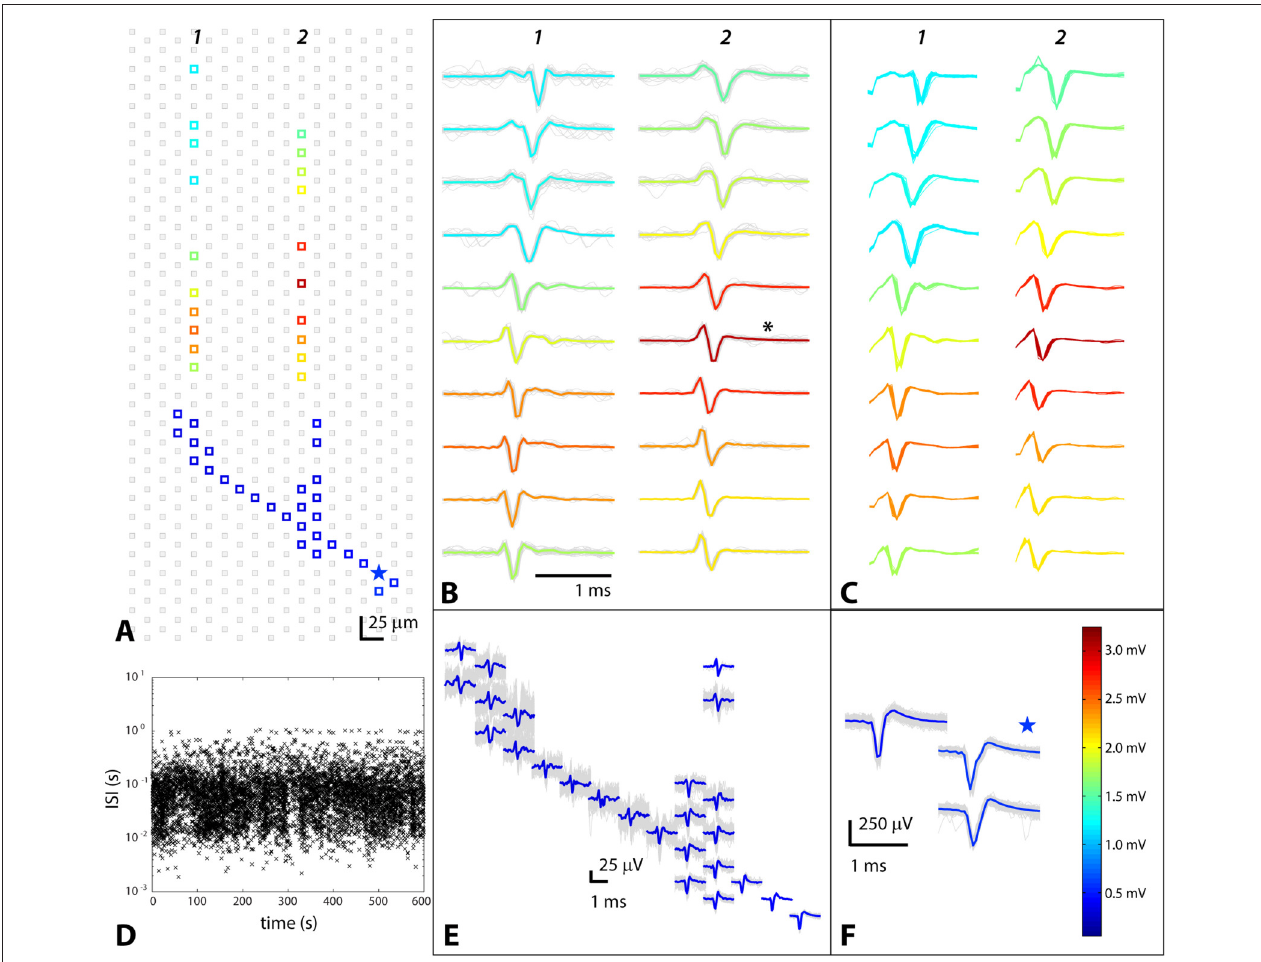
FIGURE 1 | Triggered spontaneous scan to identify axon and axonal branches belonging to a cell whose somatic location was known. Data from electrodes near the soma were spike sorted, and the resulting spike times were correlated with spikes on other electrodes on the chip. The colors of the spikes encode their amplitude, as indicated by the scale bar in (F) . (A) Positions of electrodes where spikes were detected, with putative soma designated by a star; (B) Spontaneous axonal waveforms in PDMS channels; asterisk denotes electrode from which data shown in Figure 2 was taken; (C) Stimulation-evoked spikes on the same electrodes as in (B) ; (D) Inter-spike interval (ISI) vs. time to illustrate spontaneous behavior of the cell; (E) Small axonal spikes outside of PDMS channels buried in noise; (F) Spikes on fixed electrodes near soma; star denotes putative soma